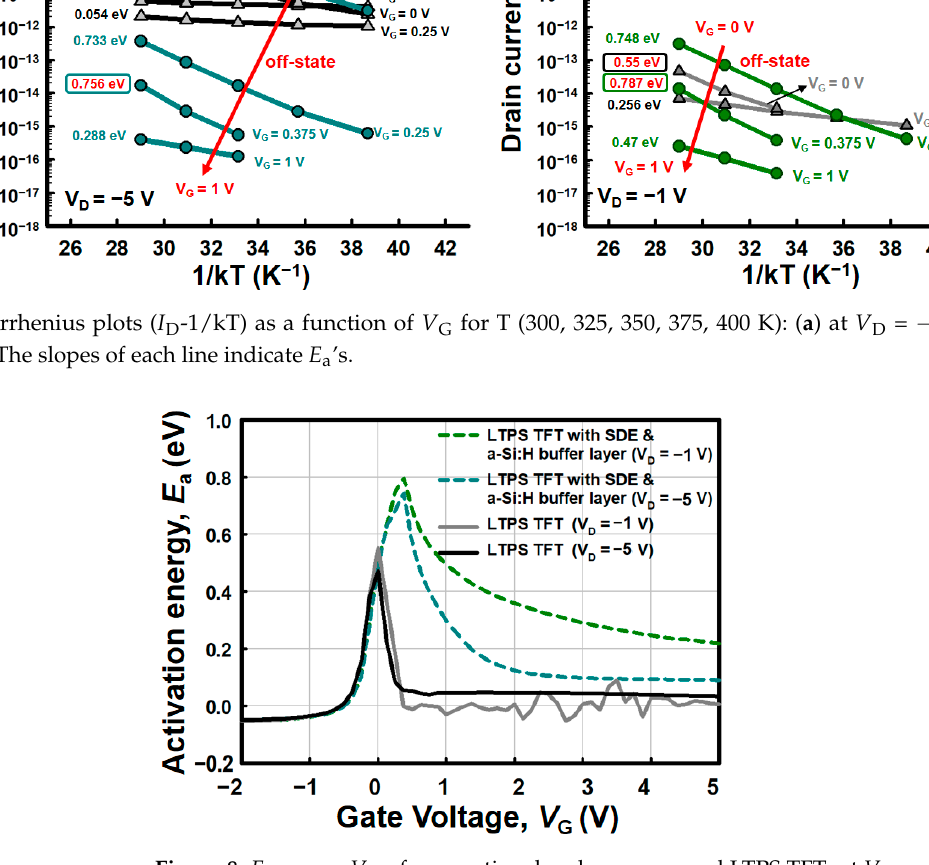
Figure 8. E a versus V G of conventional and our proposed LTPS TFTs at V D = − 1 V and V D = − 5 V .